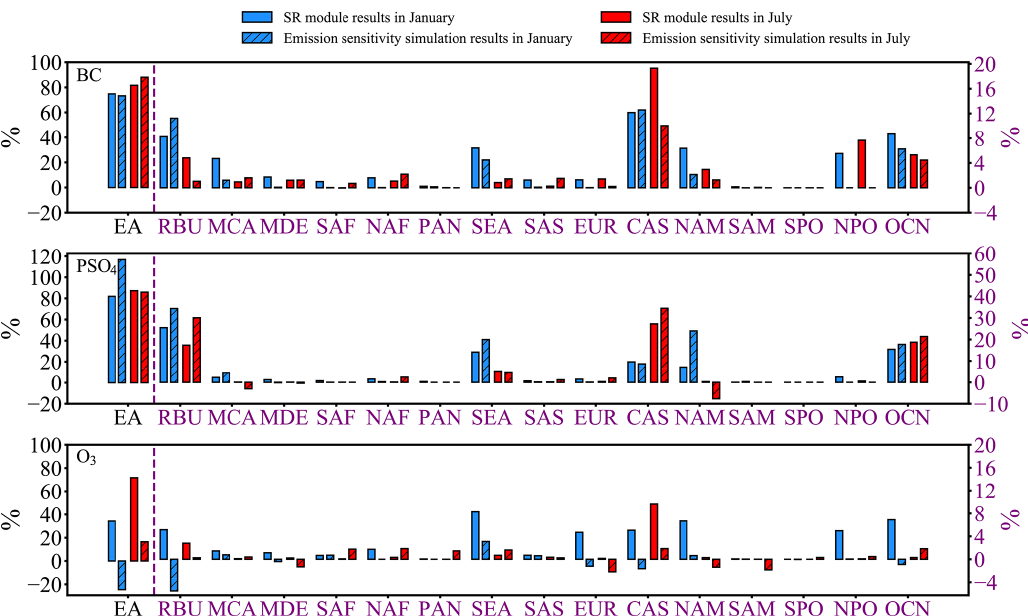
Figure 18. BC, nss-sulfate within the PBL and surface O 3 contribution from S-R module results and full response from emission sensitivity simulation results from EA source region in January and July. The y axis of receptor region EA is the coordinate axis on the left shown in black, and the y axis of other receptor regions is the coordinate axis on the right shown in